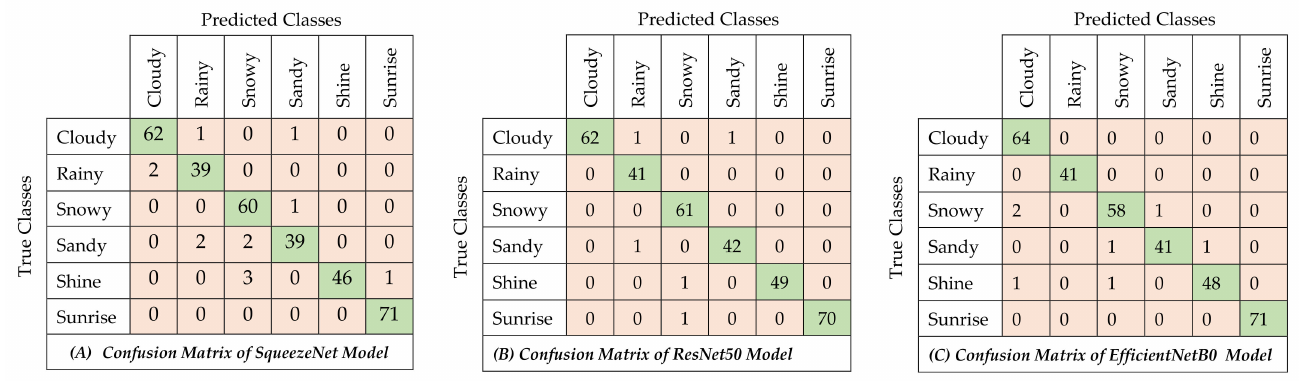
Figure 11. Six-class confusion matrix analysis for models based on ( A ) SqueezeNet CNN, ( B ) ResNet- 50 CNN, and ( C ) EfficientNet-b0 CNN.